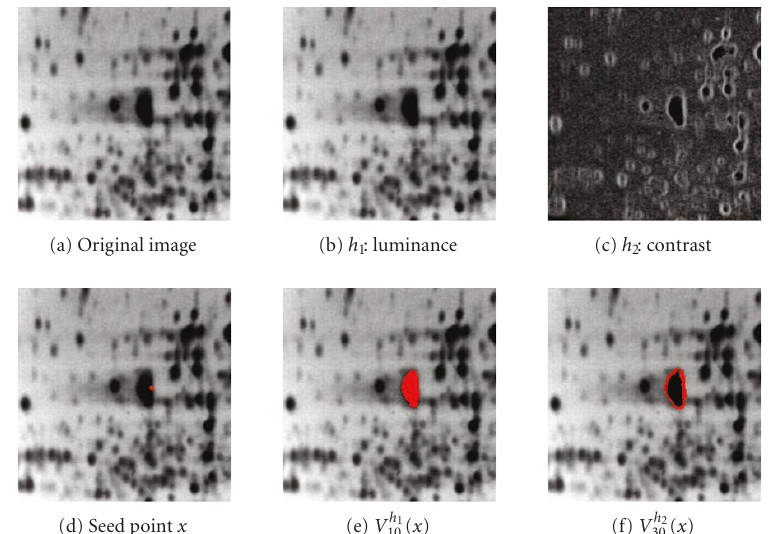
Figure 2: Original electrophoresis gel image (a). The adaptive neighborhood set for the seed point highlighted in (d) is, respectively, homo- geneous in (e) and (f), according to the tolerance m = 10 and m (c).